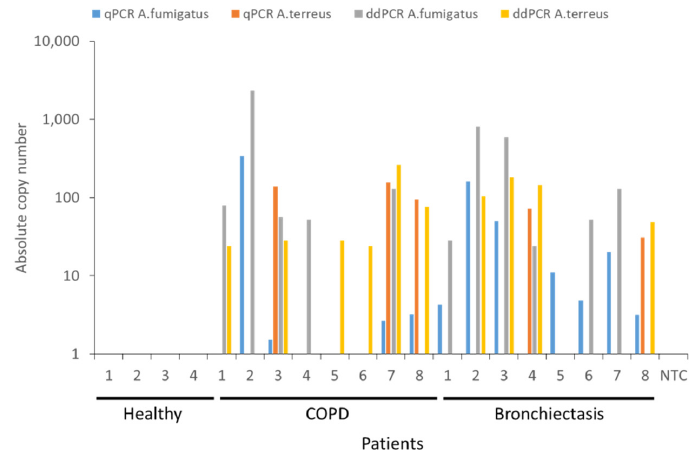
Figure 4. Head-to-head comparison between qPCR and ddPCR for the detection of A. fumigatus and A. terreus burden in non-diseased (healthy) individuals ( n = 4) and patients with COPD ( n = 8) or bronchiectasis (B, n = 8). Quantification obtained from TaqMan qPCR is indicated in blue for A. fumigatus and orange for A. terreus, respectively. Quantification by ddPCR is indicated in gray for A. fumigatus ) and yellow for A. terreus, respectively. NTC: no template control, Asp: Aspergillus , qPCR: quantitative polymerase chain reaction, ddPCR: droplet digital PCR, COPD: chronic obstructive pulmonary